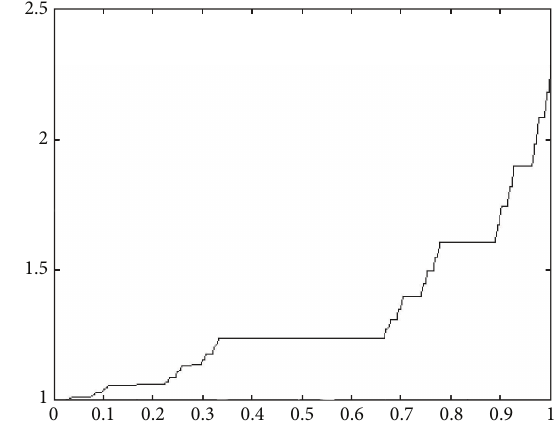
Figure 6: Graph of cosh 𝛼 𝑥 𝛼 for 𝛼 = ln 2/ ln 3